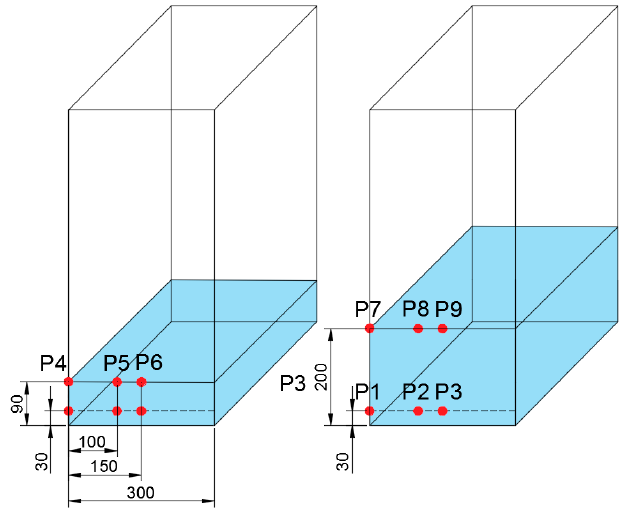
Figure 11. The locations of pressure probes.